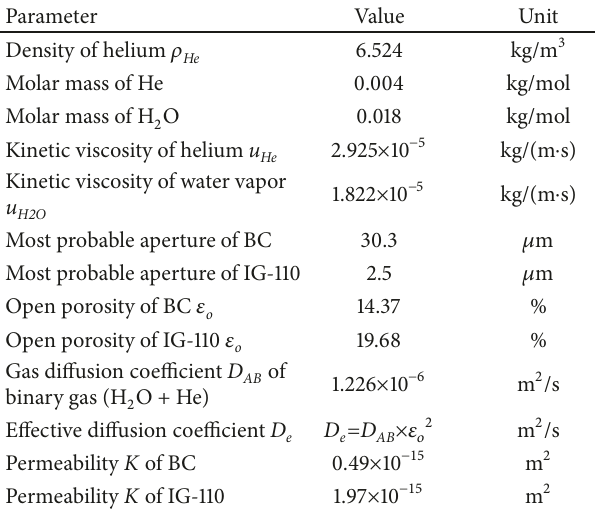
Table 4: Some parameters of model (250 ∘ C, 7 MPa).